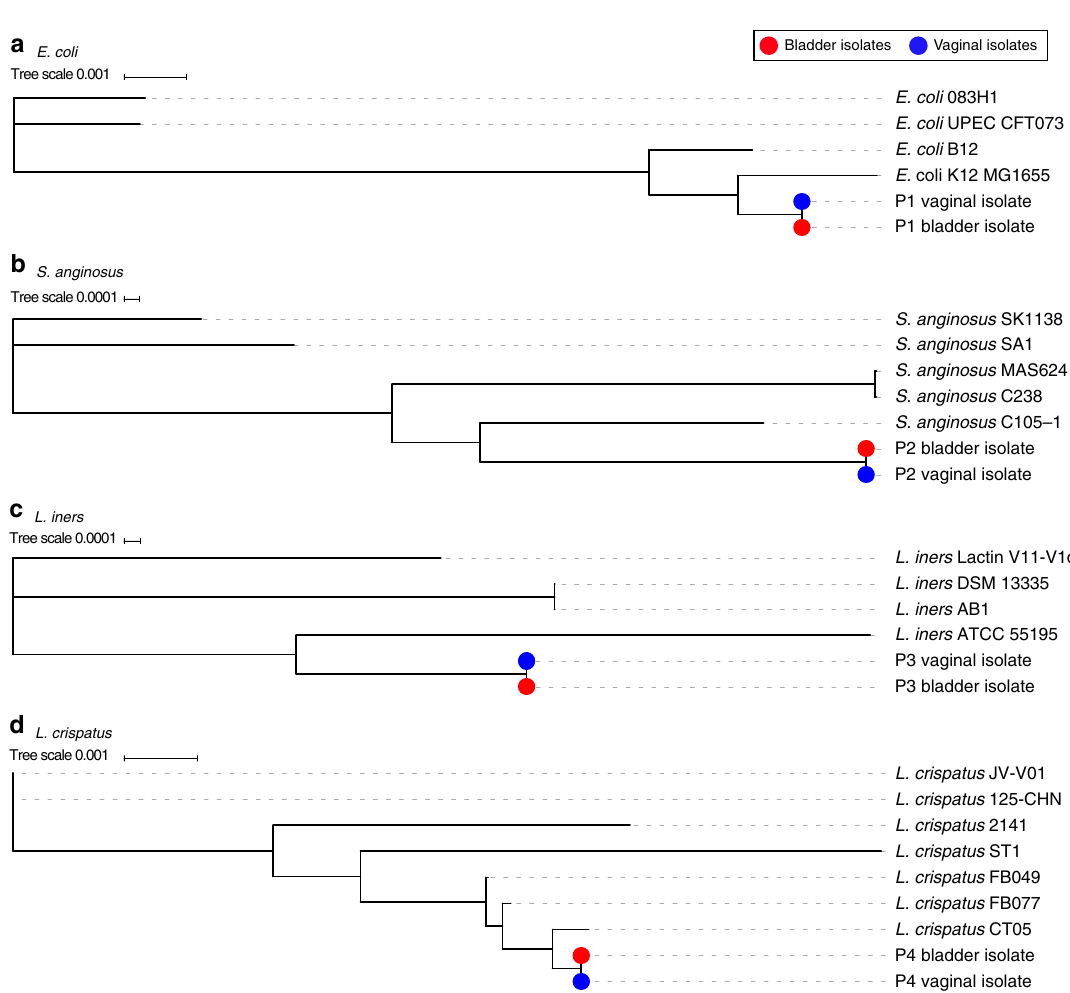
Fig. 3 Phylogenetic comparison of bladder and vaginal strains isolated from individual women using the 40 universal core genes. a Maximum likelihood tree constructed from E. coli strains isolated from the bladder (red) and vagina (blue) of individual patient (P1) and four reference strains. b Maximum likelihood tree constructed from S. anginosus strains isolated from the bladder (red) and vagina (blue) of individual patient (P2) and fi ve reference strains. c Maximum likelihood tree constructed from L. iners strains isolated from the bladder (red) and vagina (blue) of individual patient (P3) and four reference strains. d Maximum likelihood tree constructed from L. crispatus strains isolated from the bladder (red) and vagina (blue) of individual patient (P4)